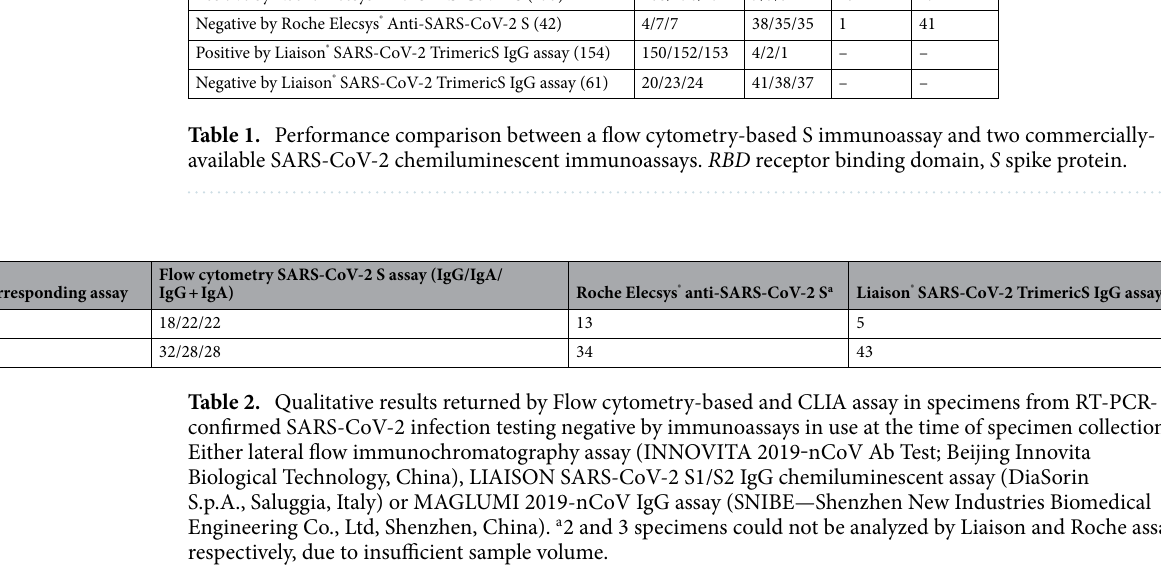
Assays under comparison (no. of specimens)